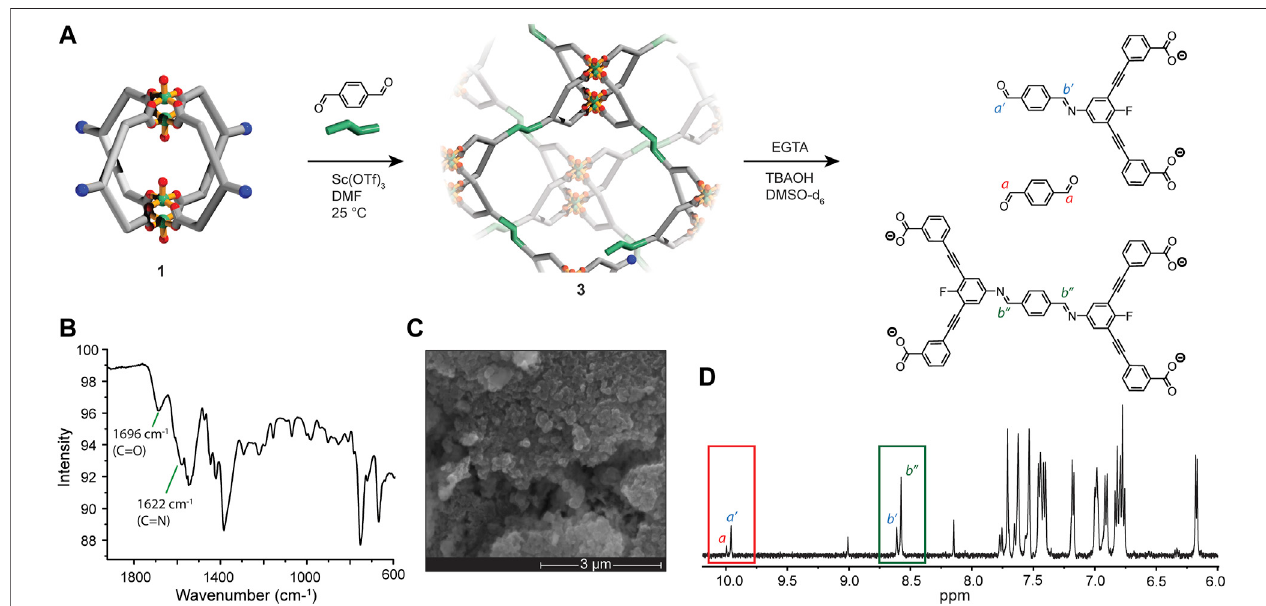
FIGURE 4 | (A ) A scheme showing the covalent-cross linking of 1 (in solution) with PDA to form 3 ; (B ) IR spectrum of 3 , showing C (cid:1) O (from carboxylate and carbonylmoieties)andC (cid:1) N(iminebond)stretches; (C) SEMimageof 3 ,50 Kmagni fi cation; (D) 1 HNMRspectrum(500 MHz,DMSO-d 6 )ofadigestedsampleof 3 ,with disassembled fragments shown above and key resonances annotated on the spectrum [unreacted L 2 is not shown in (A) ].